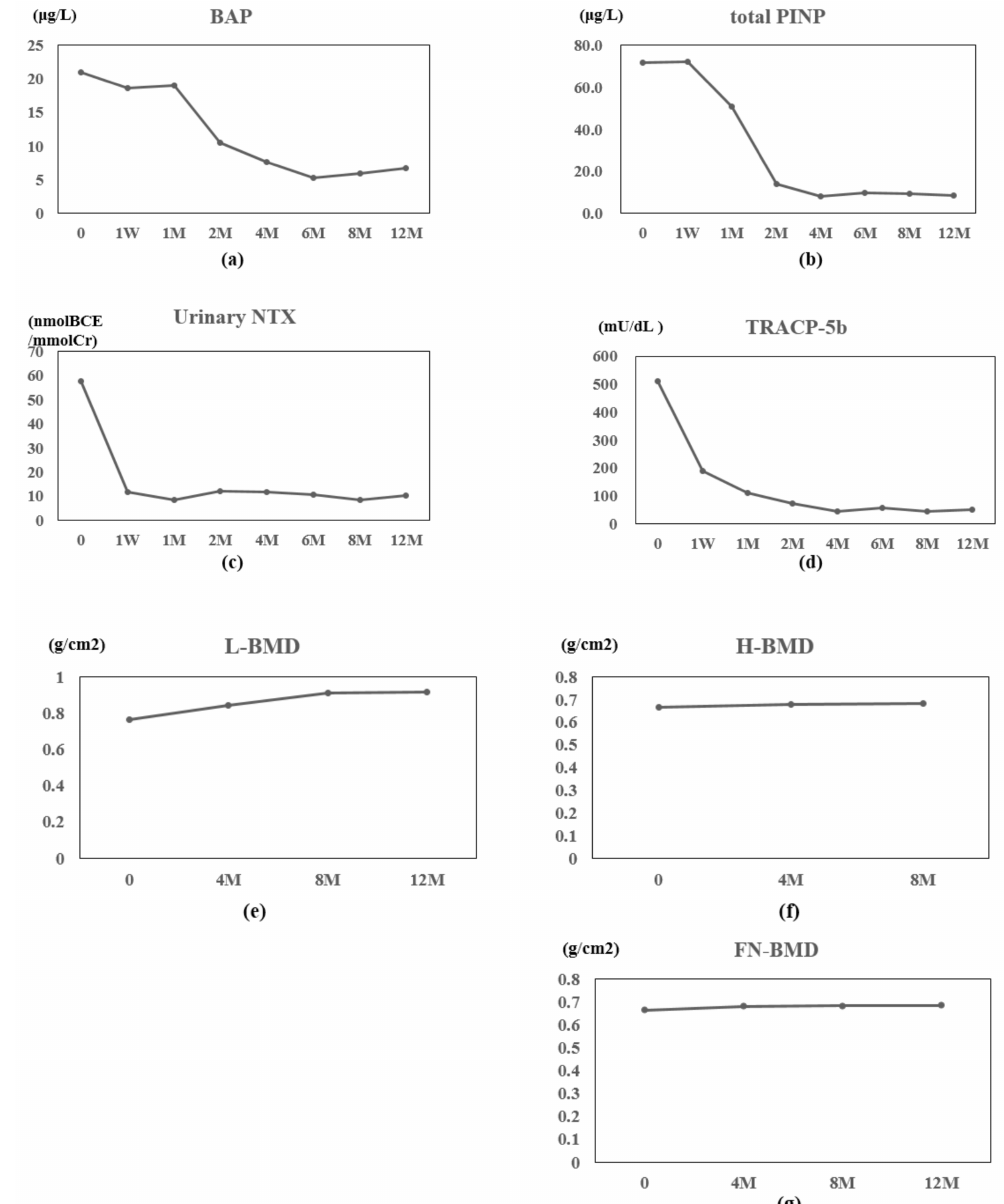
Figure 2. Patient 2 data: Value changes in bone alkaline phosphatase (BAP) ( a ), type I procollagen N-terminal propeptide (total P1NP) ( b ), urinary N-terminal telopeptide of type-I collagen (Urinary NTX) ( c ), and tartrate-resistant acid phosphatase (TRACP)-5b ( d ). before and at one week (W) and one, two, four, six, eight, and 12 months (M) of denosumab therapy. Value changes in lumbar 1–4 bone mineral density (L-BMD) ( e ), total hip BMD (H-BMD) ( f ), and femoral neck BMD (FN-BMD) ( g ) at the indicated time